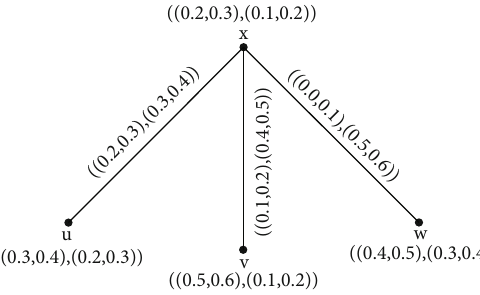
ð u Þ = d ð x Þ = ðð 0 : 1,0 : 3 Þ , ð 0 : 2,0 : 4 ÞÞ and G G